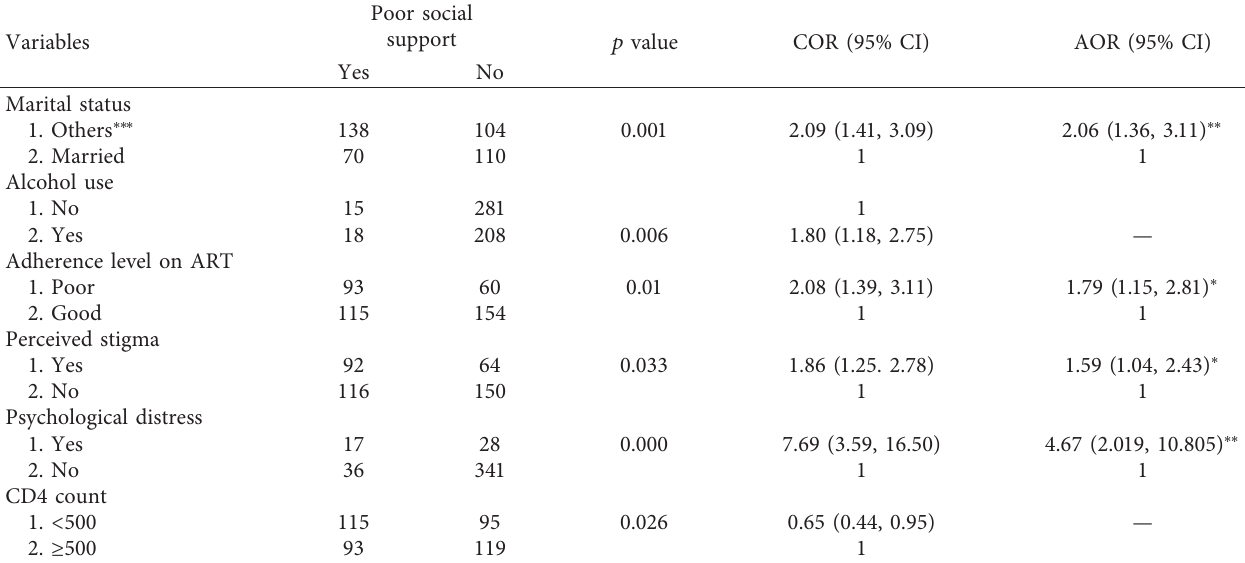
Table 3: Factors associated with poor social support among PLHIV at selected hospitals, North Shewa Zone, Amhara Regional State, Ethiopia, 2017 ( n �